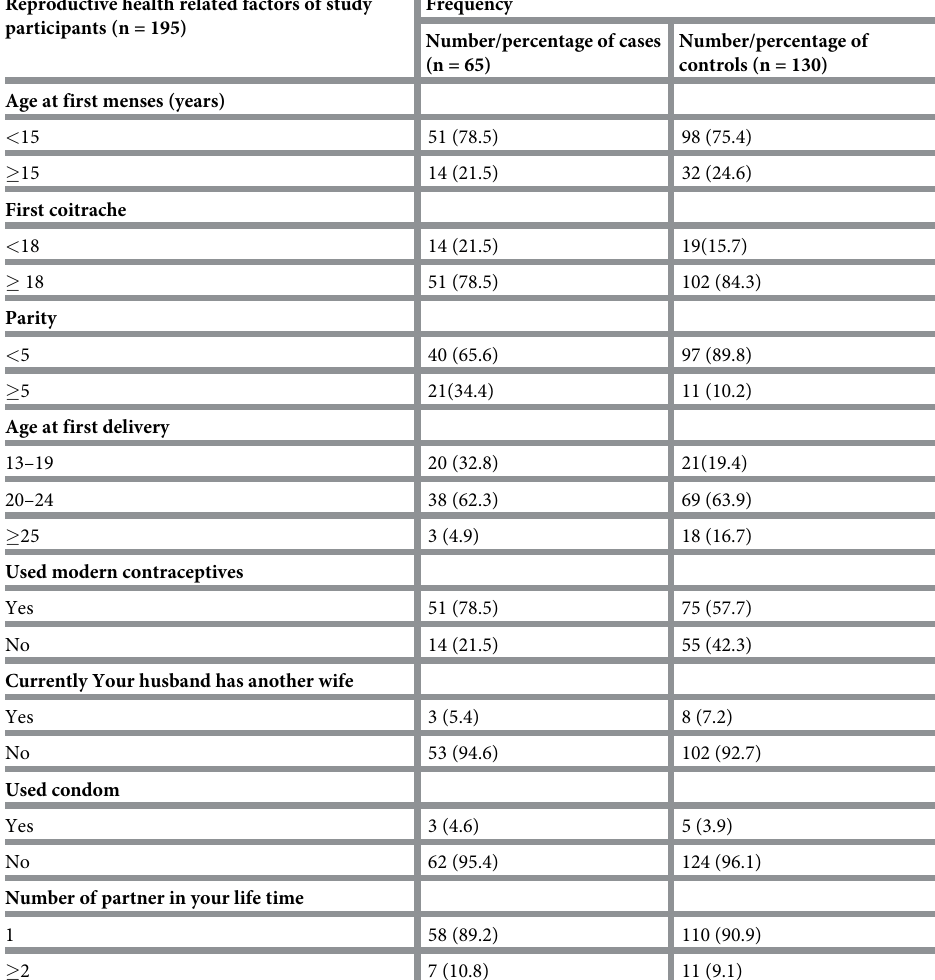
Table 2. Reproductive health related factors of women in the age group of 30–49 years in Ambo town, Oromia Regional State, Ethiopia, February to March